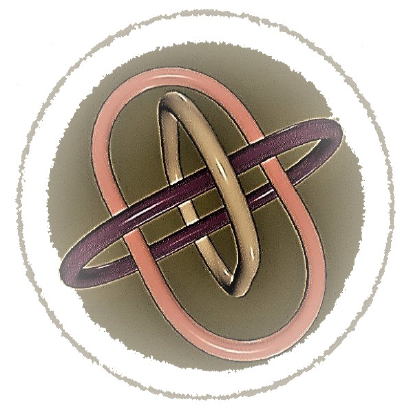
Figure 2. The tripartite Borromean